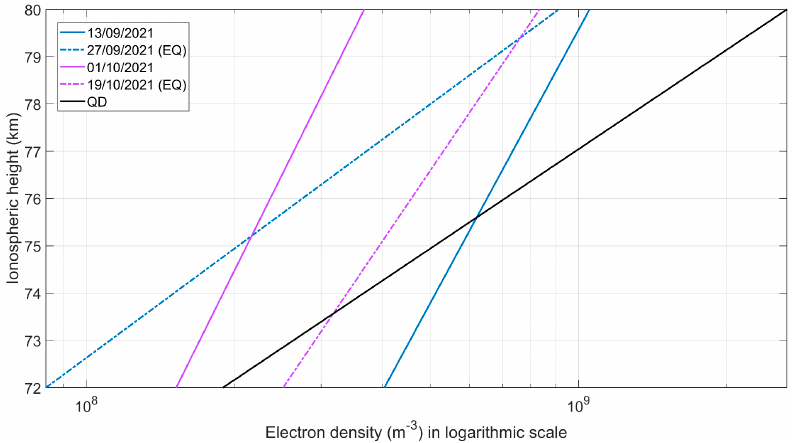
Figure 11. Same as Figure 9 for SST2 of ISR–UWA path .